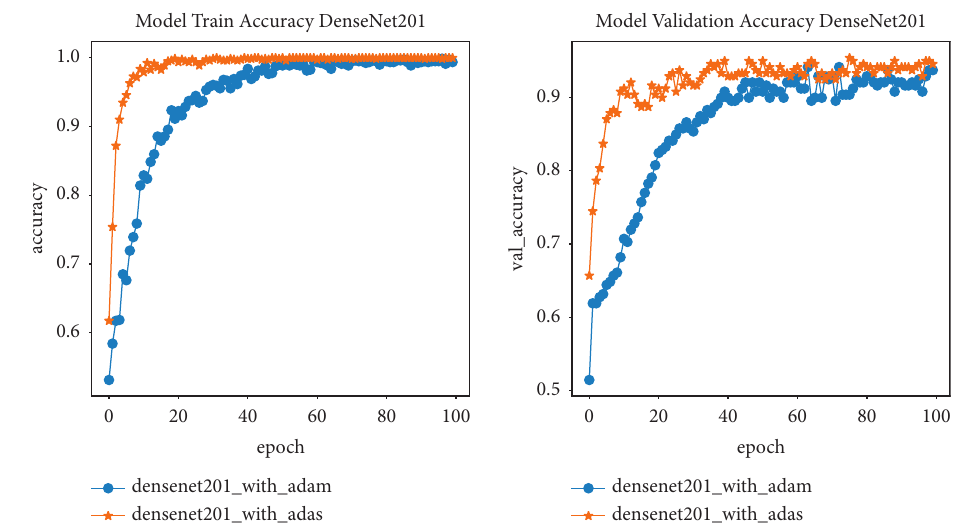
Figure 17: Accuracy of DenseNet201 network architectures using ADAM and ADAS optimization